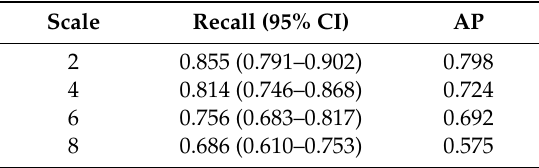
Table 7. The impact of the scale on the model